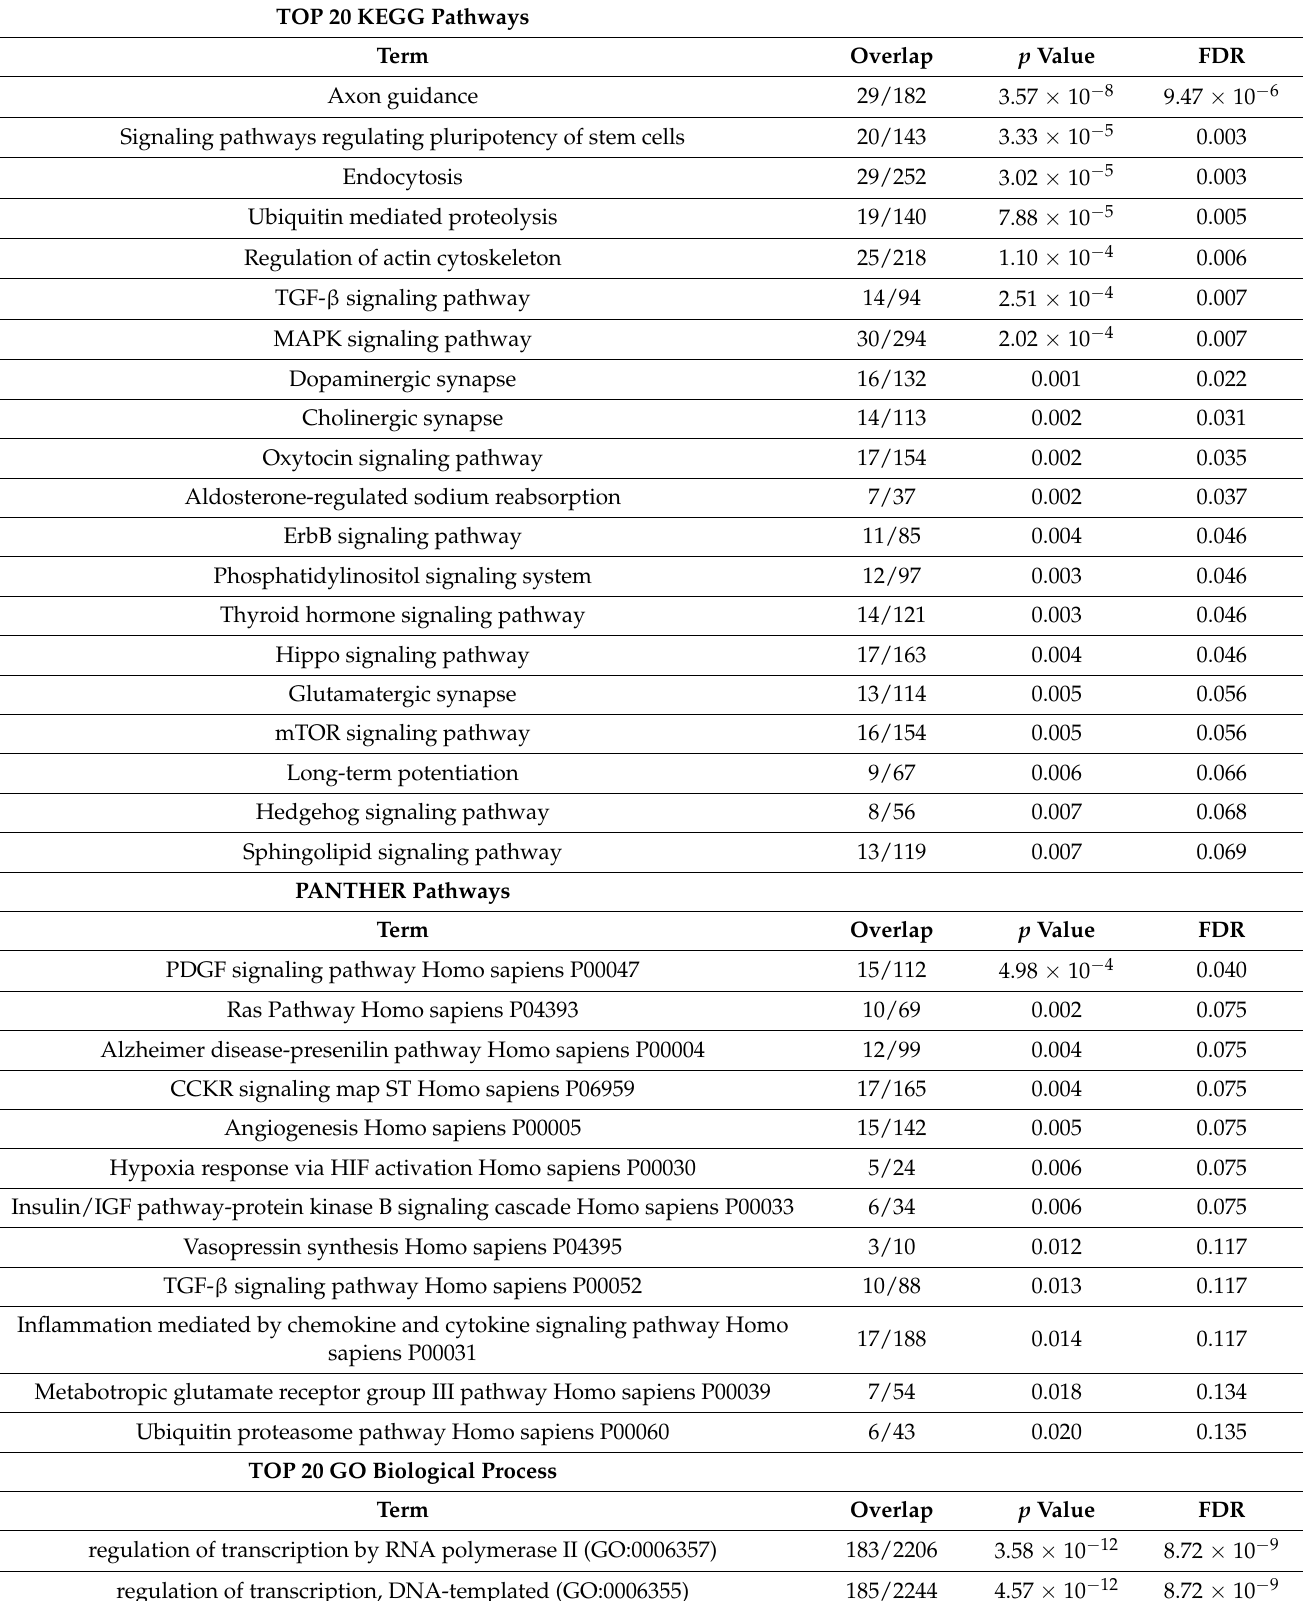
Table 3. Bioinformatic analysis of miR-142-5p target genes. The table reports the most representative terms of pathways and the GO analysis of miR-142-5p target